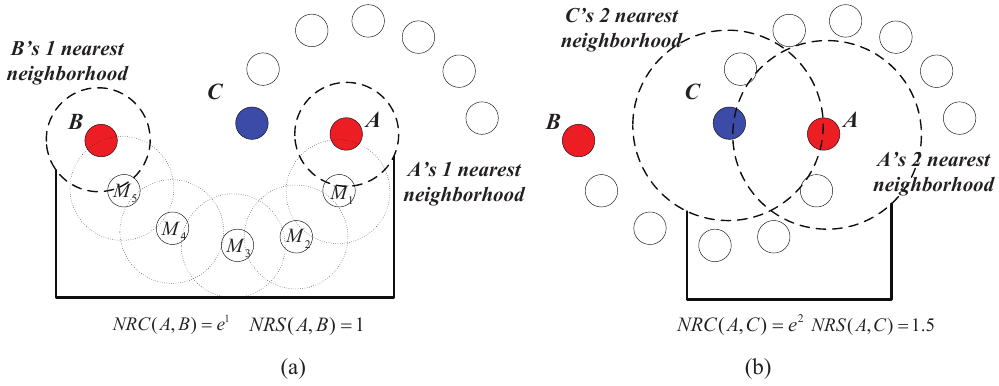
Figure 7. ( a ) Value of the closeness Measure based on the Neighborhood Chain ( CMNC ) between A and B . ( b ) Value of CMNC between A and C